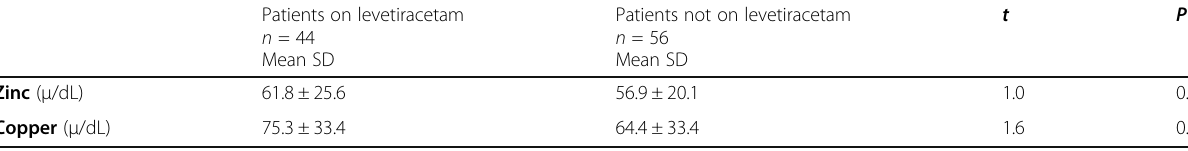
Table 5 Comparison between patient with and without levetiracetam intake as regards zinc and copper serum levels Patients on levetiracetam n =